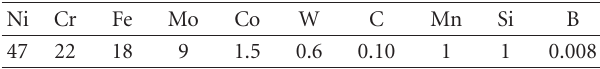
Table 1: Nominal chemical composition (wt%) of Hastelloy-X